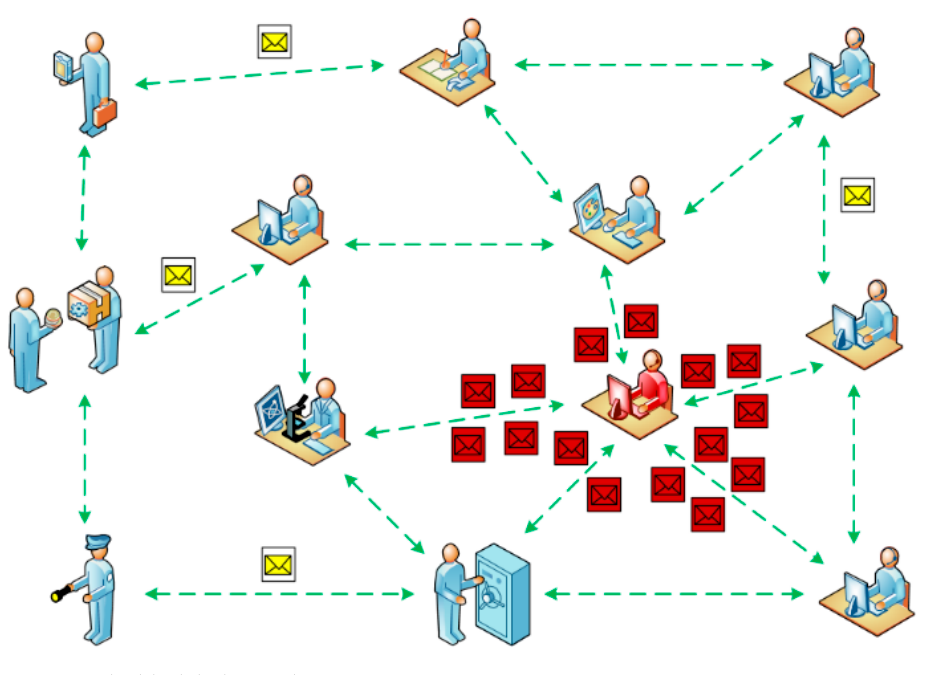
Figure 5. The black hole attack case.